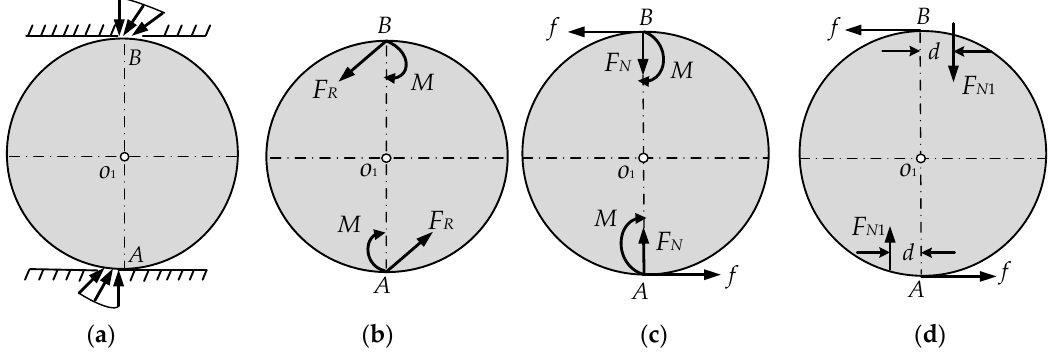
Figure 6. Force decomposition diagram of the steel ball. ( a ) The real force diagram of the ball; ( b ) The simplified force diagram of the sensor; ( c ) The decomposition diagram of (b); ( d ) The equivalent offset diagram of the steel ball.